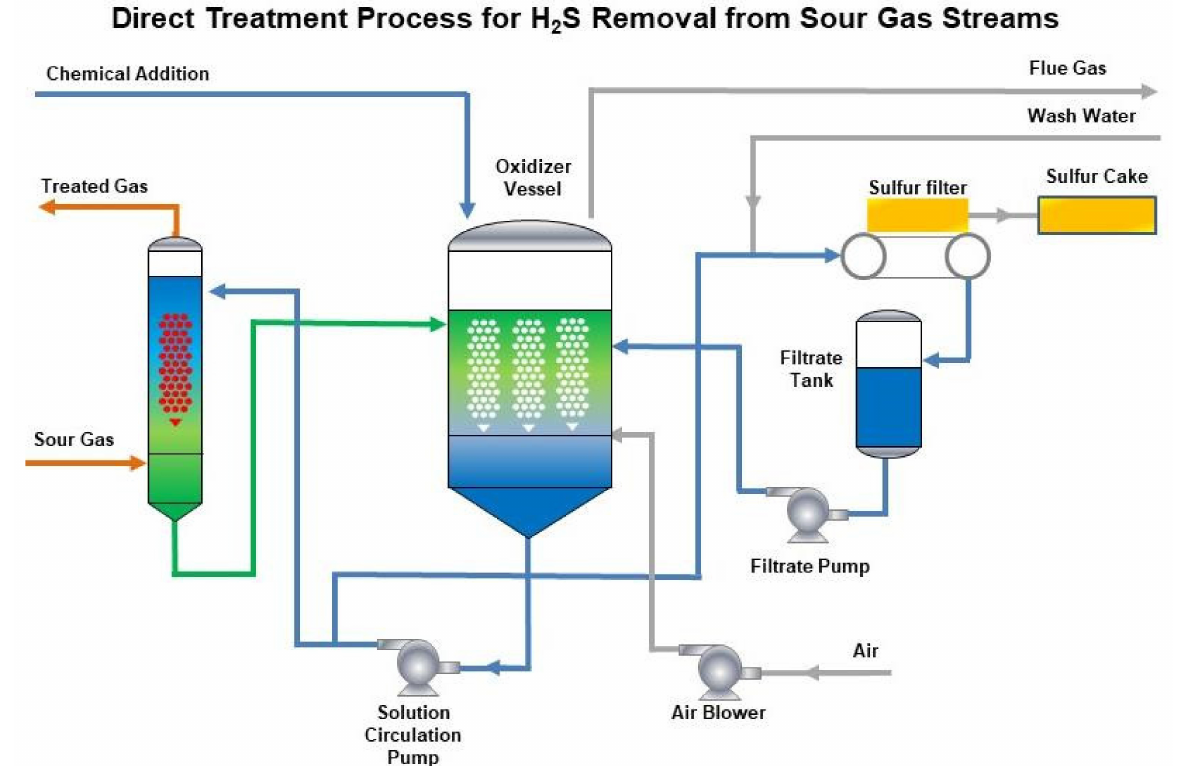
Figure 1. Schematic of the Lo-Cat process (adapted from